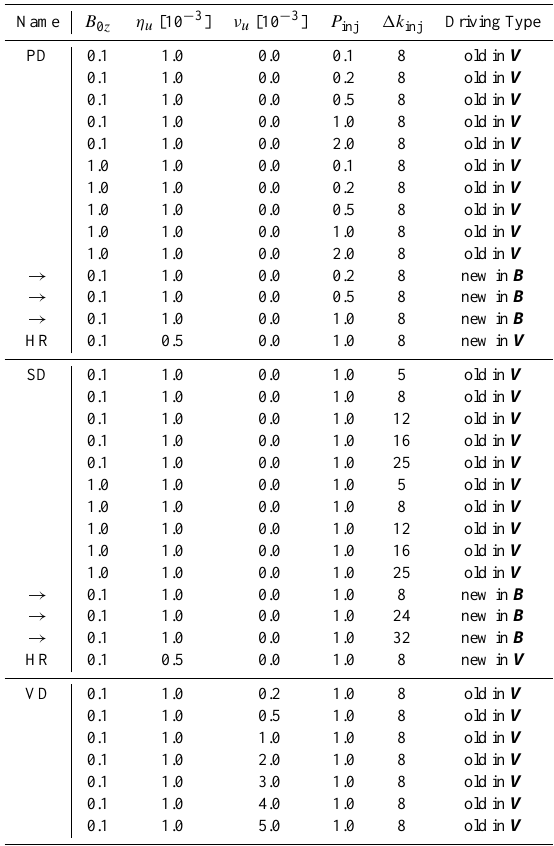
Table 1. List of